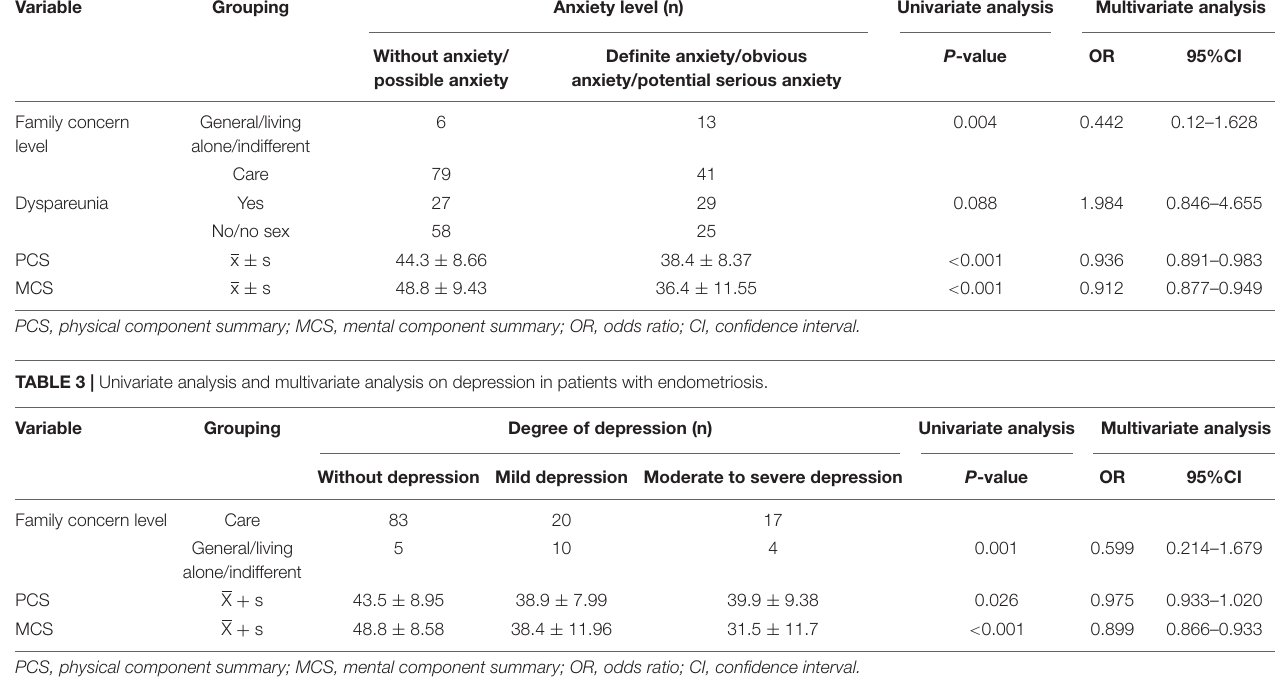
TABLE 2 | Univariate analysis and multivariate analysis on anxiety in patients with endometriosis. Variable Grouping